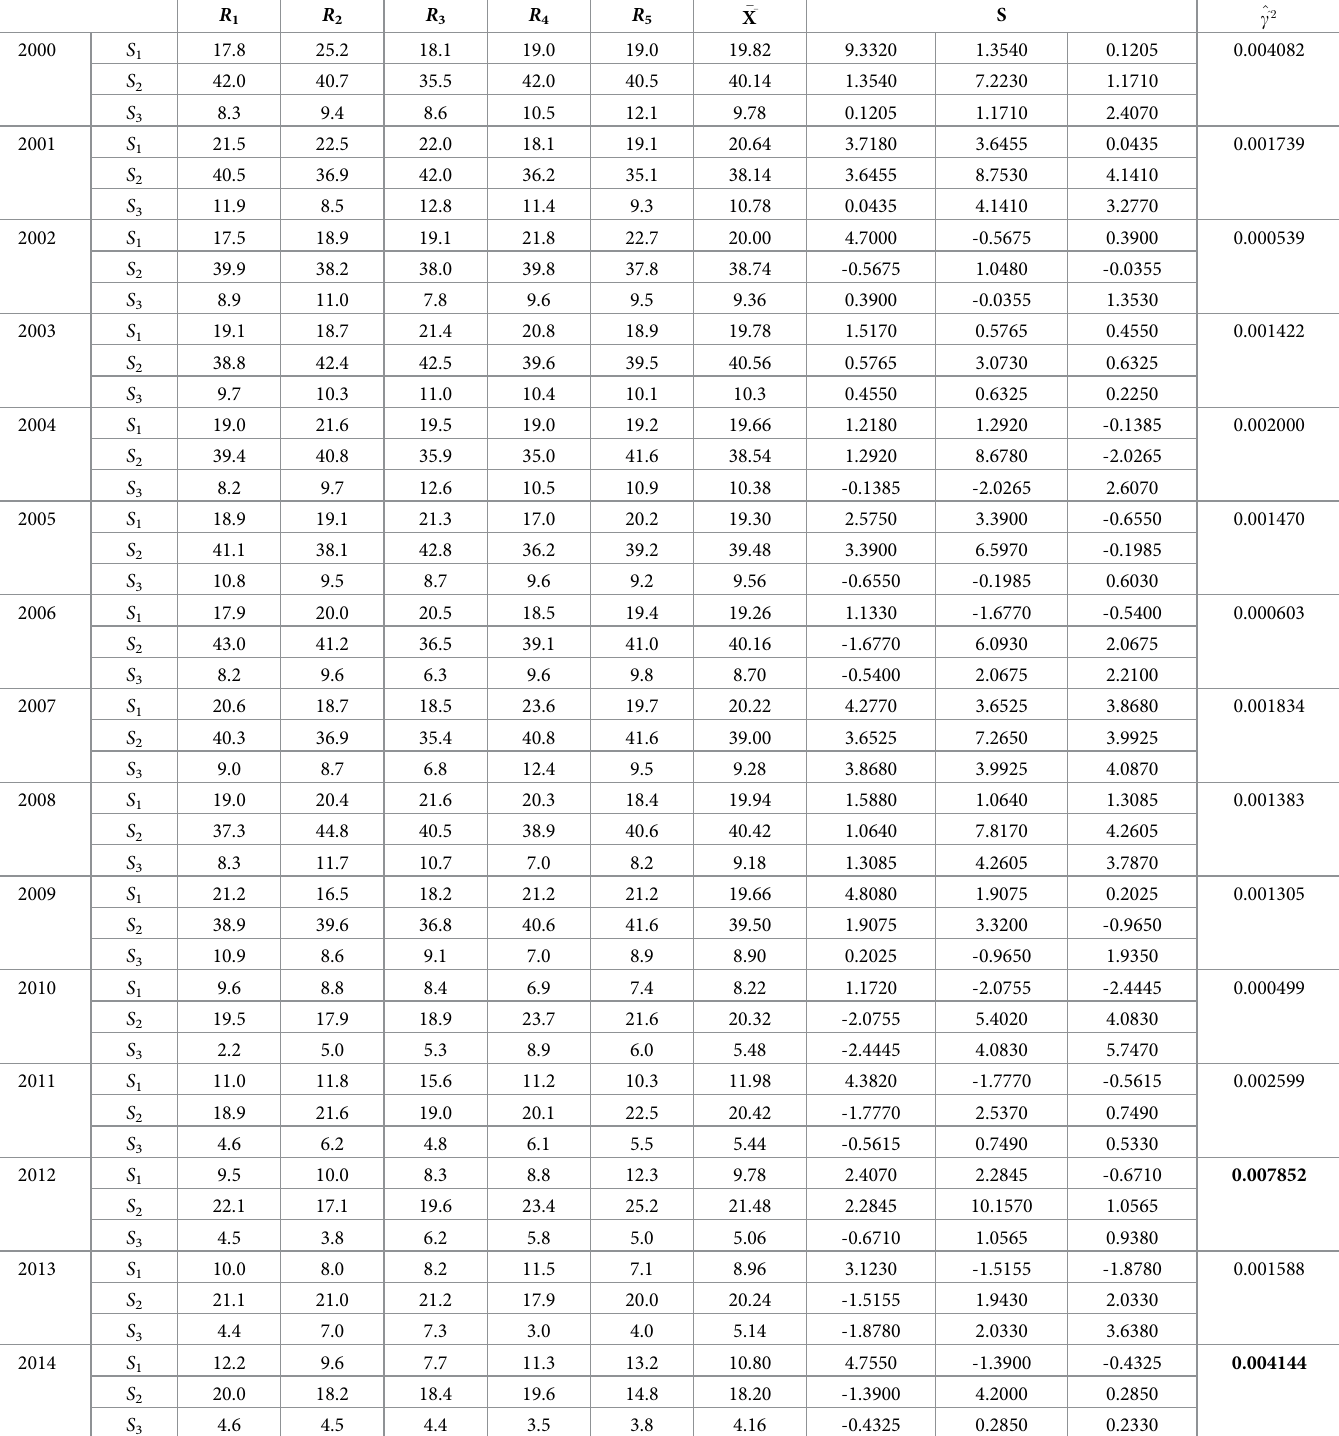
Table 9. Rates of return (in %) from 2000 to 2016 for p = 3 industrial sectors { S 1 , S 2 , S 3 } and n = 5 regions { R 1 , R 2 , R 3 , R 4 , R 5 }. R